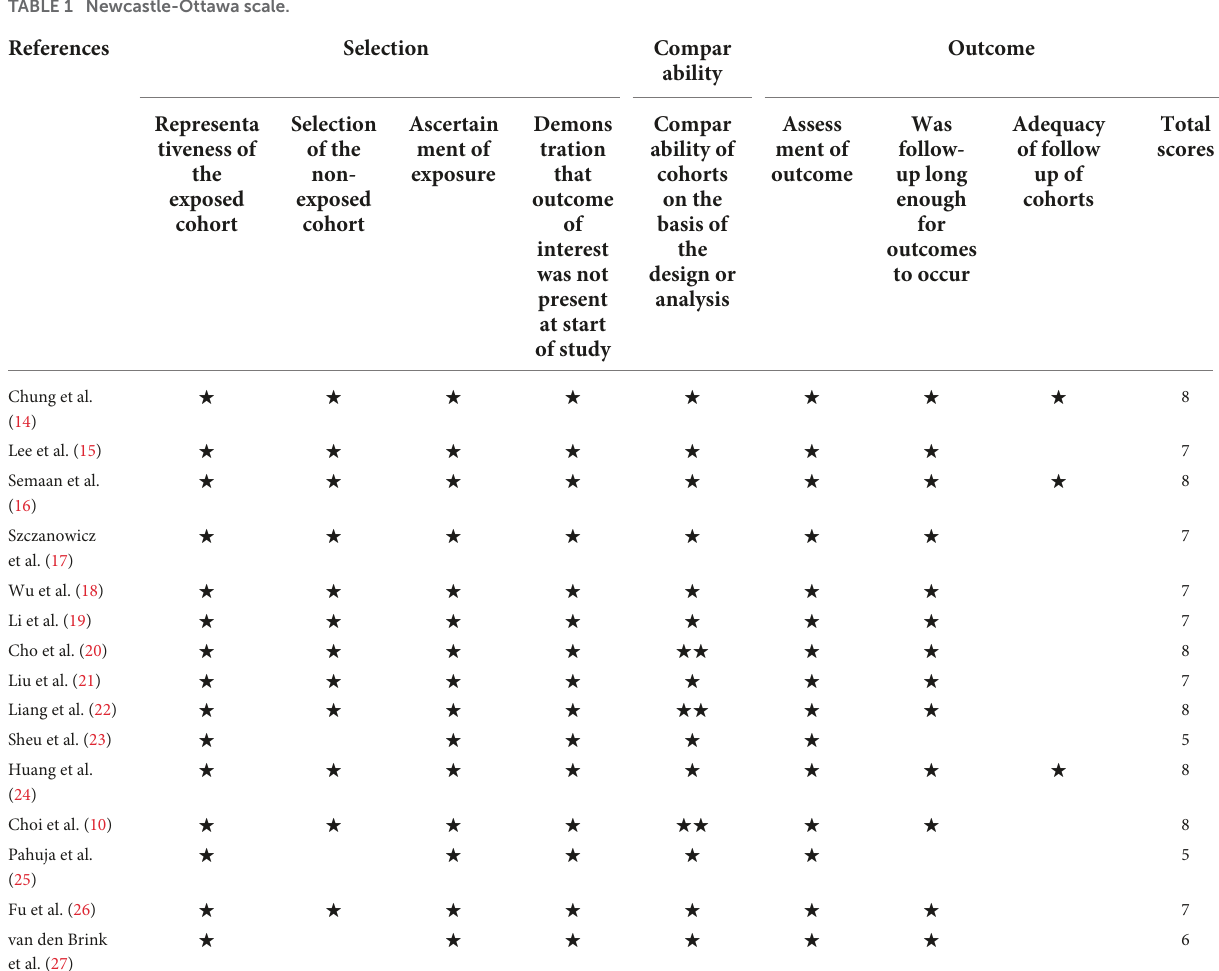
TABLE 1 Newcastle-Ottawa